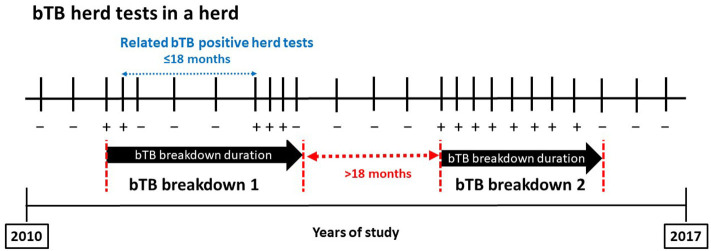
Diagram of bovine tuberculosis (bTB) breakdown definition. Plus and minus signs denote bTB-positive and bTB-negative tests, respectively.